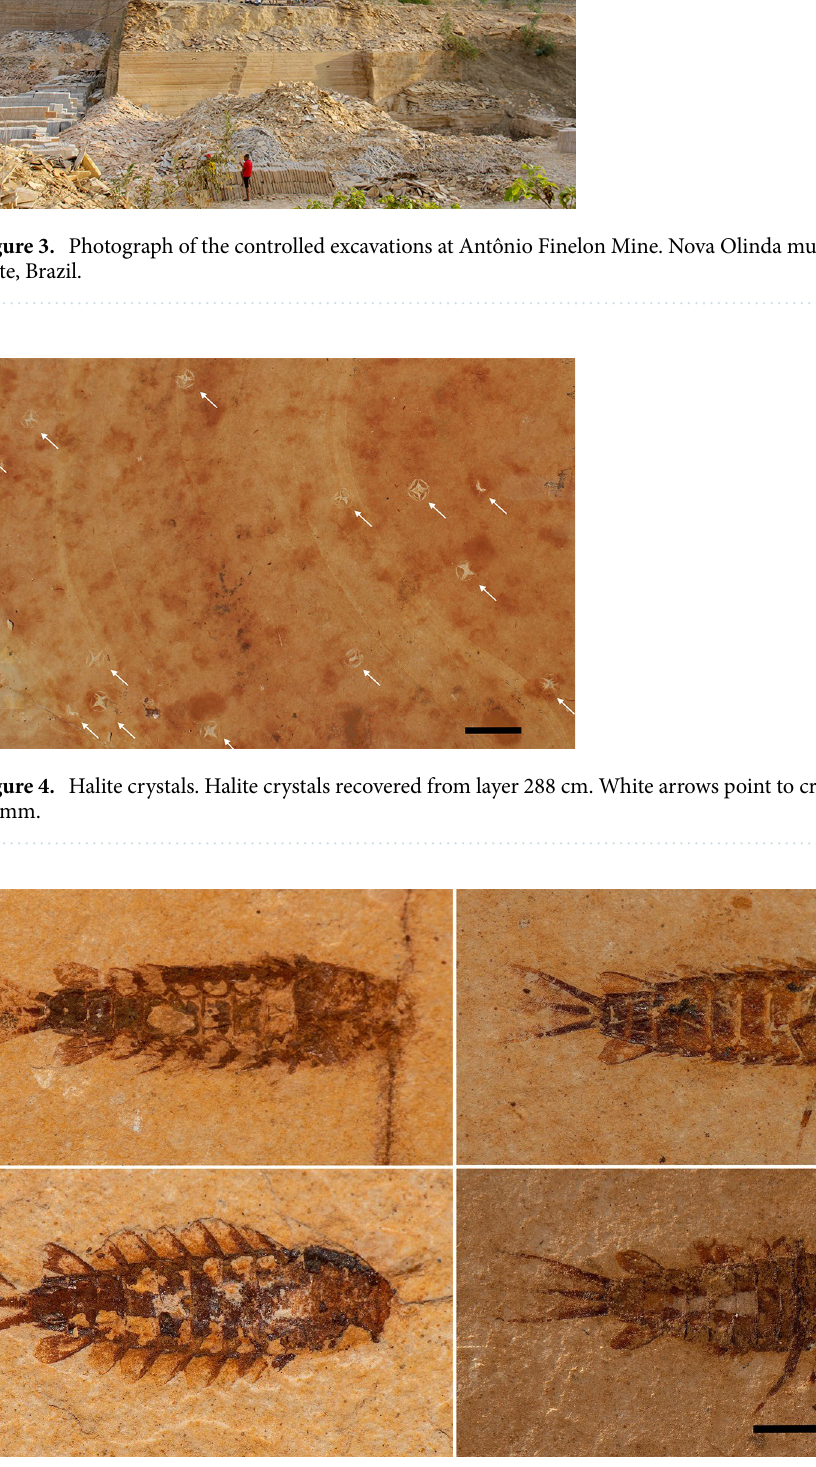
Figure 5. Preservation of larvae from layer 285 cm. Larvae of Protoligoneuria limai recovered from layer 285 cm, evidencing the excellent preservation of specimens. Scale bar 5